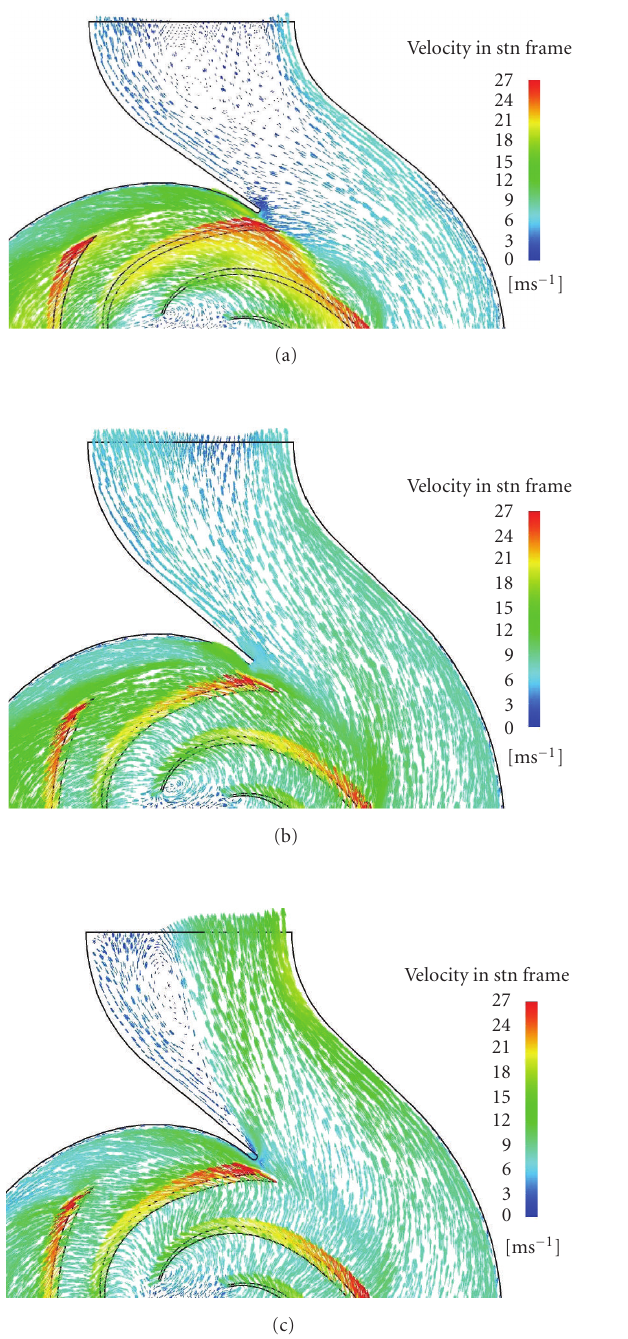
Figure 7: Velocity vector at volute di ff user at di ff erent flow rate. (a) O ff -design point, Q = 0.43 Q design . (b) Design point, Q design . (c) O ff -design point, Q = 1.45 Q design .